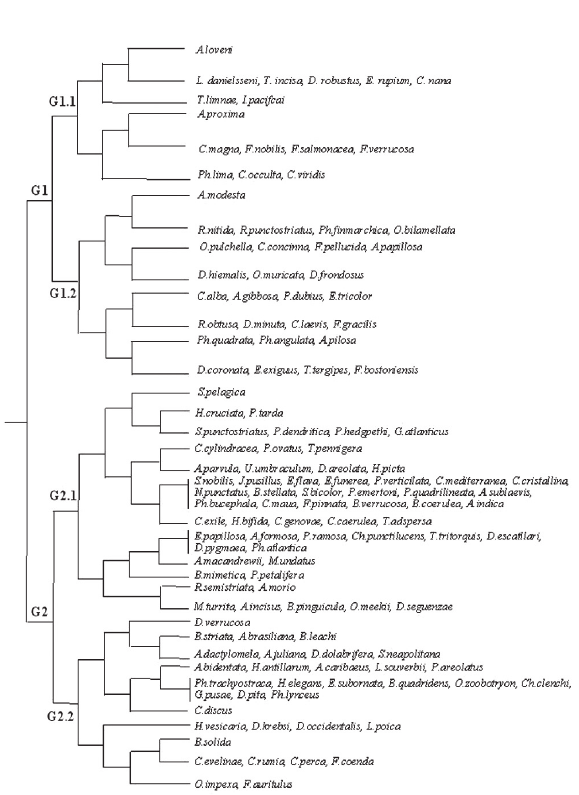
Fig . 3. – Results from TWINSPAN analysis based on the presence- absence of amphiatlantic species in the biogeographic